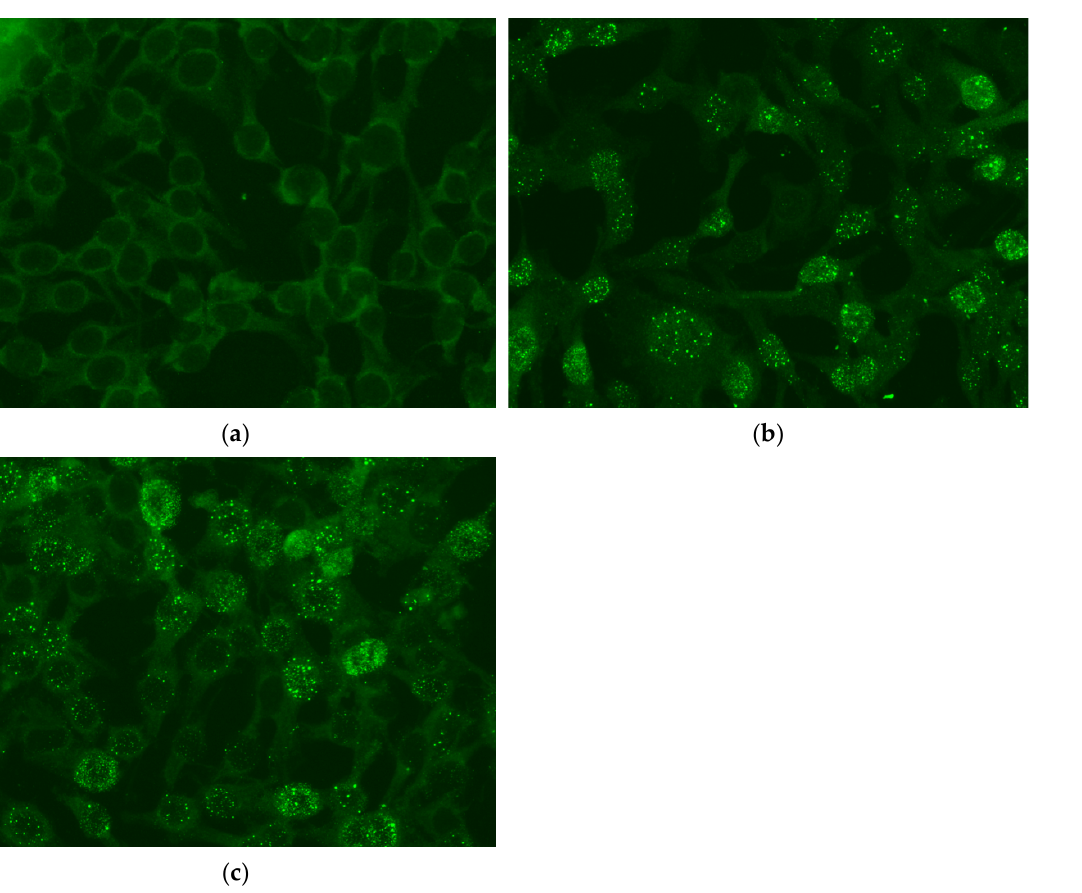
Figure 2. ( a ) No detection of anti-PaBV antibodies from yolk sample B0.1/4 before seroconversion (titer < 1:10) by indirect immunofluorescence assay (IIFA) on CEC-32 cells, 200× total magnification; ( b ) anti-PaBV antibody detection from yolk sample B0.1/5 after seroconversion (titer 1:640) by indirect immunofluorescence assay (IIFA) on CEC-32 cells, 200× total magnification; ( c ) anti-PaBV antibody detection from yolk sample J11/81 (titer 1:1280) by indirect immunofluorescence assay (IIFA) on CEC-32 cells, 200× total magnification.